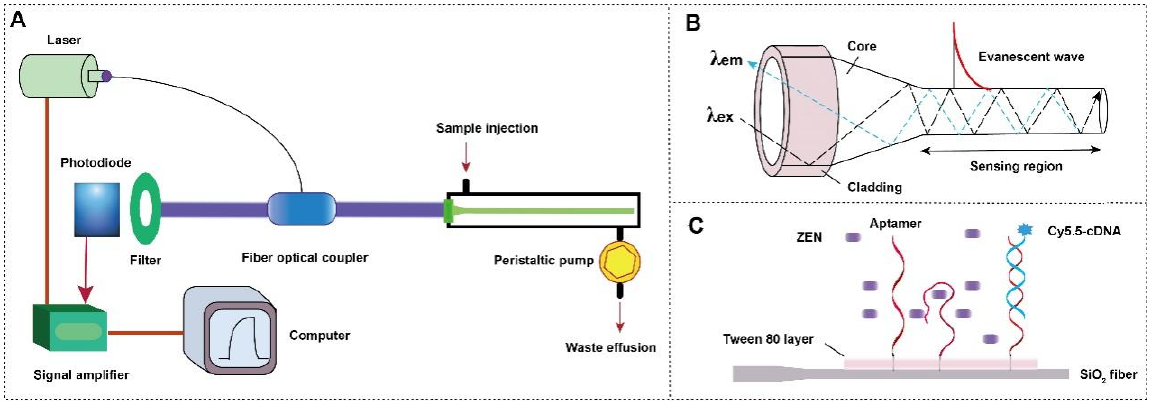
Figure 1. ( A ) The components of a typical EWOF sensor; ( B ) the structure of the tapered fiber and the evanescent wave generated vertical to the fiber surface; and ( C ) the working principle of NADL-EWOF.